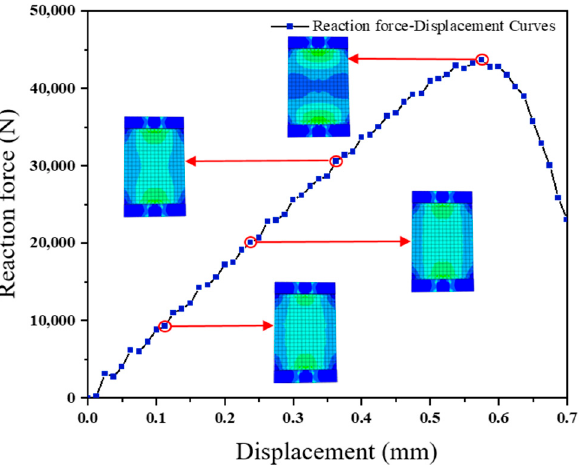
Figure 4. Reaction force–displacement curve of the hierarchical stiffened plate.